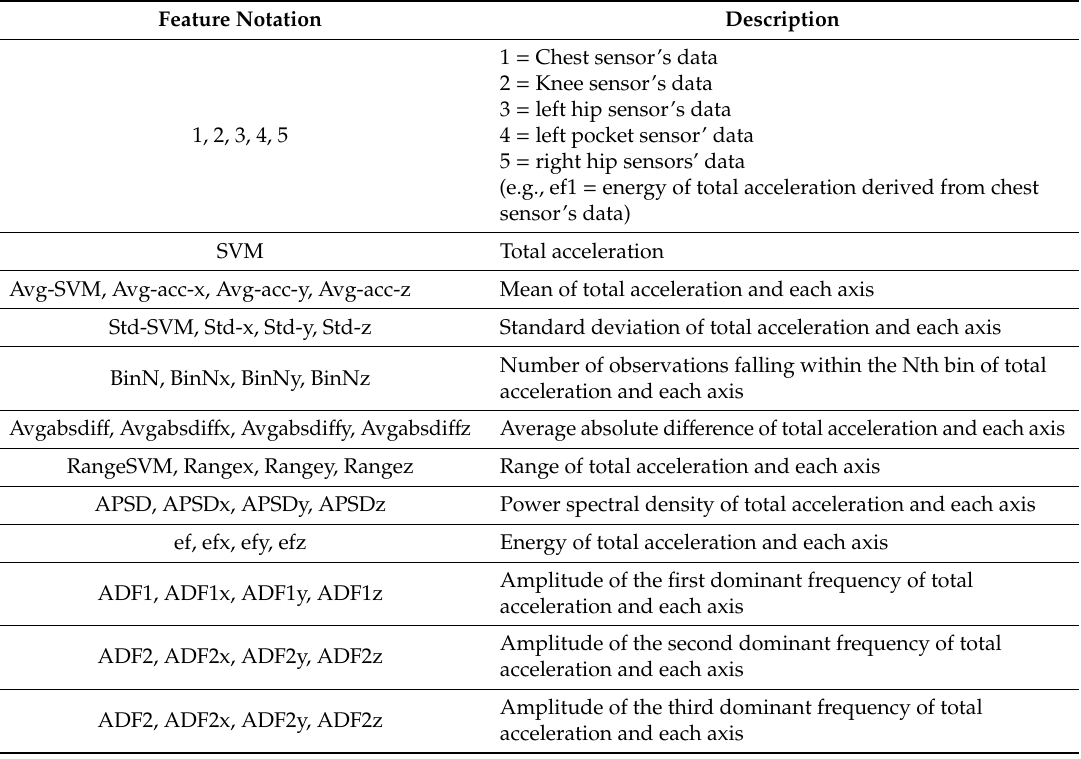
Table A3. List of features appearing in Figures A2 and A3.